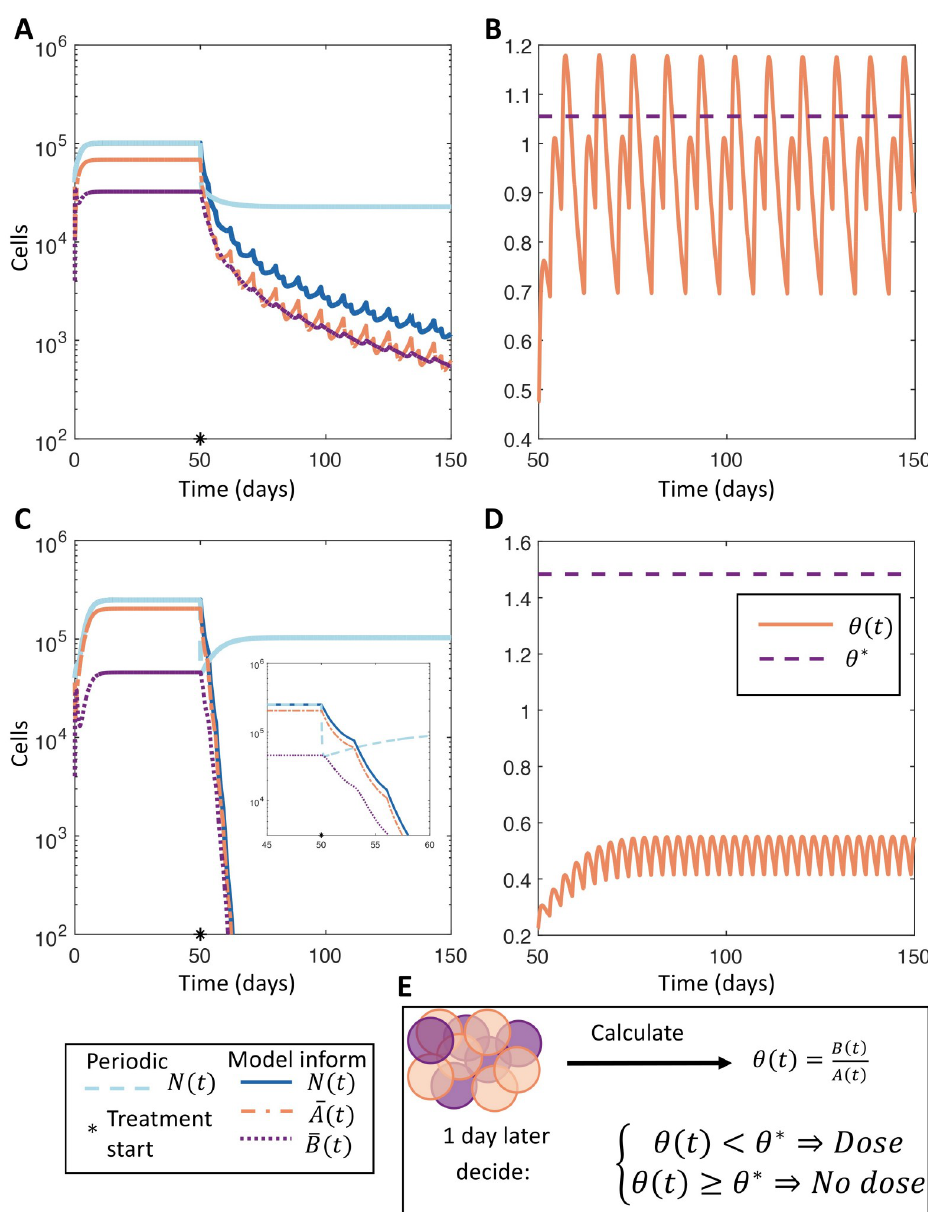
Fig 5. Comparing model-informed and periodic dosing treatment regimens. A and C ) Comparison of model- informed therapeutic strategy with T = 3 against periodic treatment with docetaxel for the WT and M1 populations, respectively. The total tumour populations under periodic or model-informed therapies are given in dashed grey or in solid blue, respectively. The drug sensitive ð � A ð t ÞÞ and drug-tolerant ð � B ð t ÞÞ sub-populations under model-informed therapy are shown in dot-dashed orange or dotted purple. The beginning of treatment on day 50 is denoted by a black star. The inset in C shows the rapid decay of the M1 tumour population during therapy. B and D ) The ratio y ð t Þ ¼ � B ð t Þ = � A ð t Þ during model-informed therapy in solid orange and the threshold ratio θ � in dashed orange for the WT and M1 populations respectively. E ) illustrates the model-informed therapy where θ ( t ) is used to decide if therapy is given or not. The model parameters used in this simulation are given in Tables C and D in S1